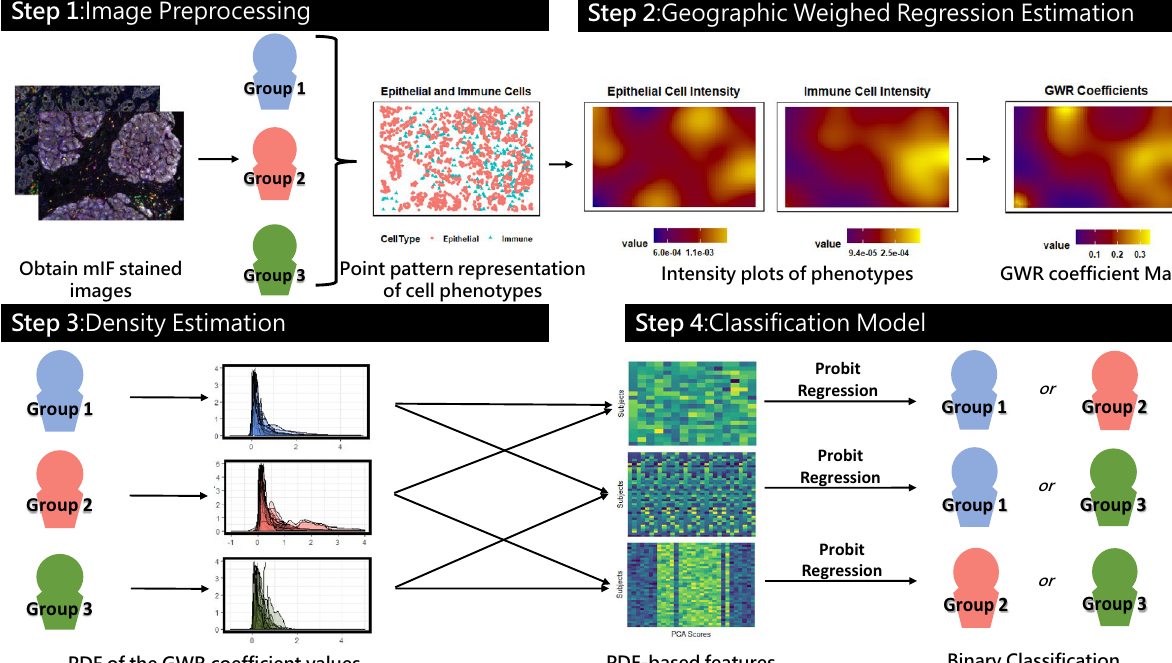
Figure 1. A schema of the proposed GaWRDenMap framework. The framework utilizes the point intensity maps of the cell phenotypes in question to generate a regression map, the values of which are used to construct a density-based feature vector. This vector is then used as an input to a classifier to distinguish between any two groups of diseases.